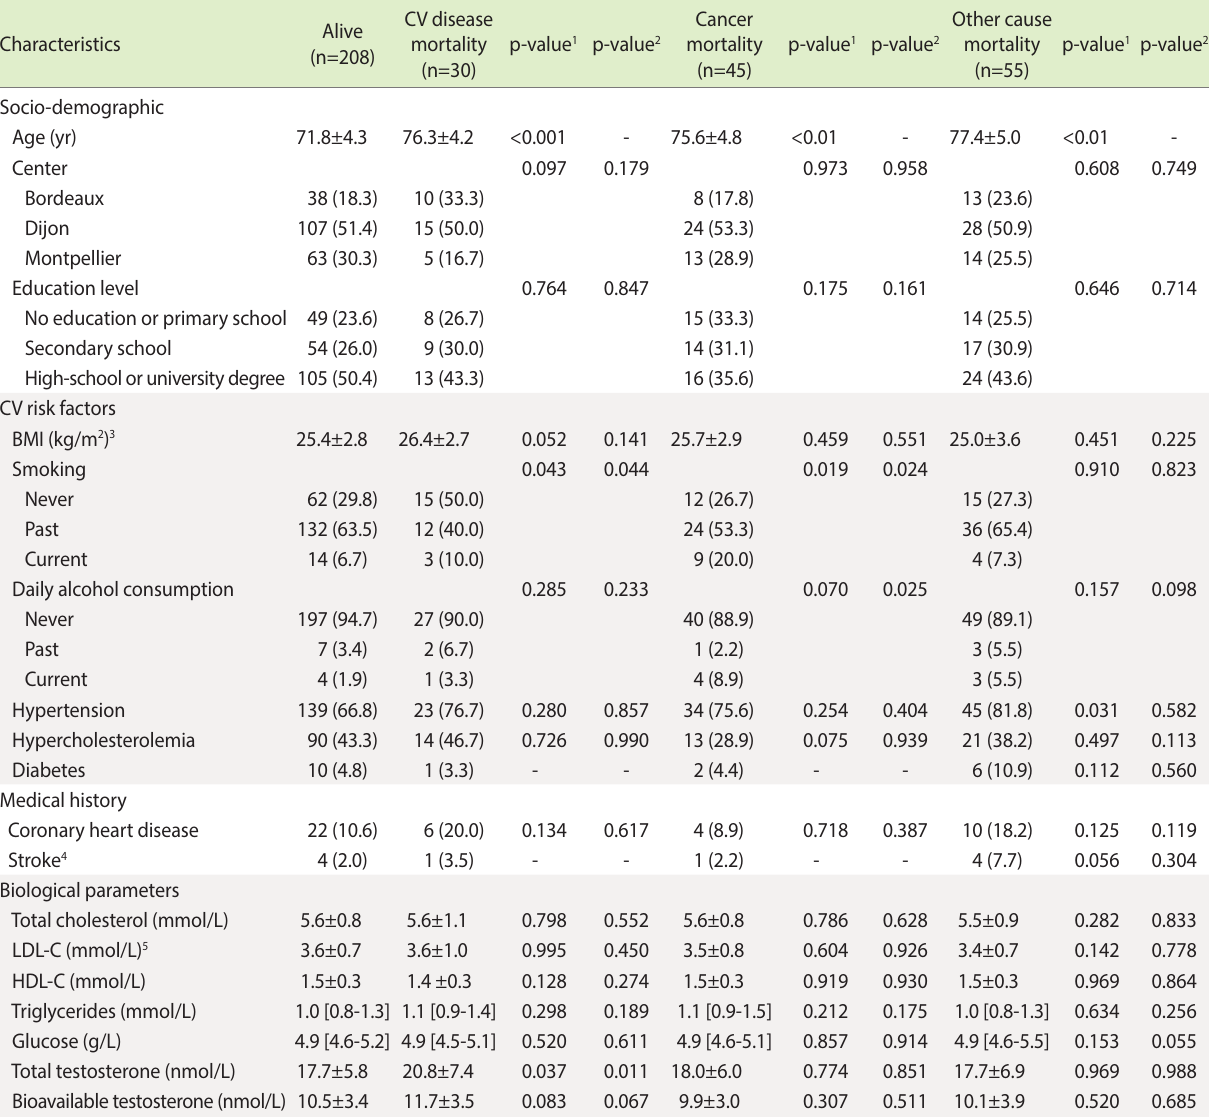
Table 1. Baseline characteristics of men without MetS according to cause-specific mortality after a 12-year follow-up in the 3C cohort study